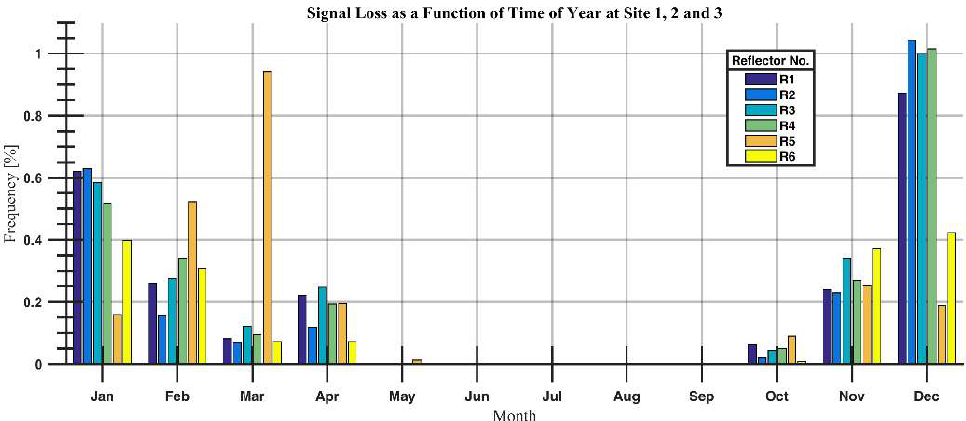
Figure 8. The percentage of time per month that the signal has fallen below the cut-off value for the measurement period. Most of the fall-outs occur in the